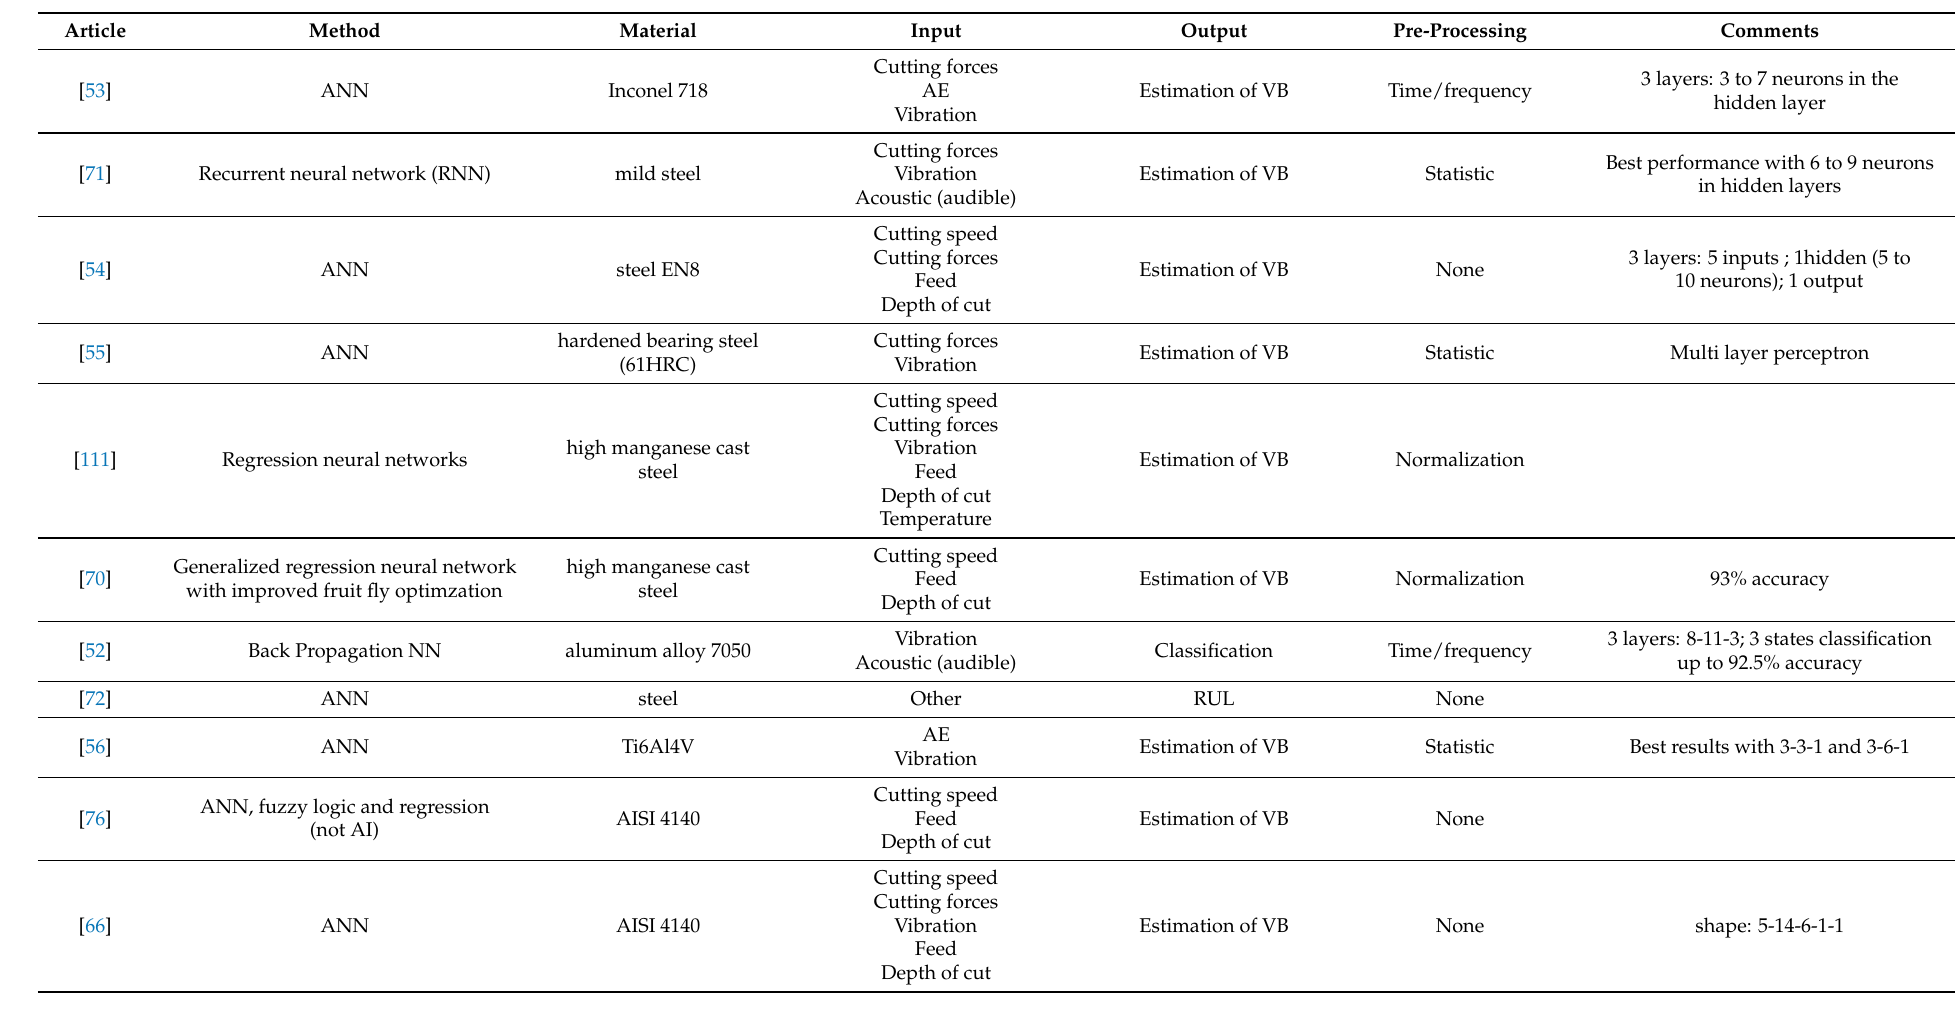
Table A1. General summary of ANN-related